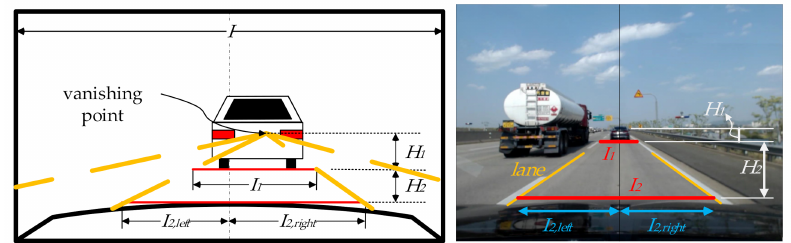
Figure 1. Image from camera mounted on vehicle.